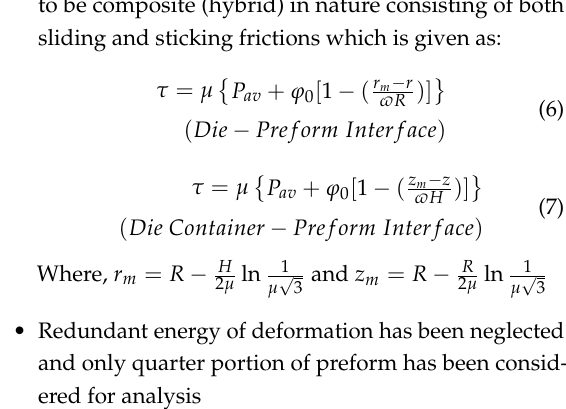
Fig. 4. Division of Elements in Deforming Preform.